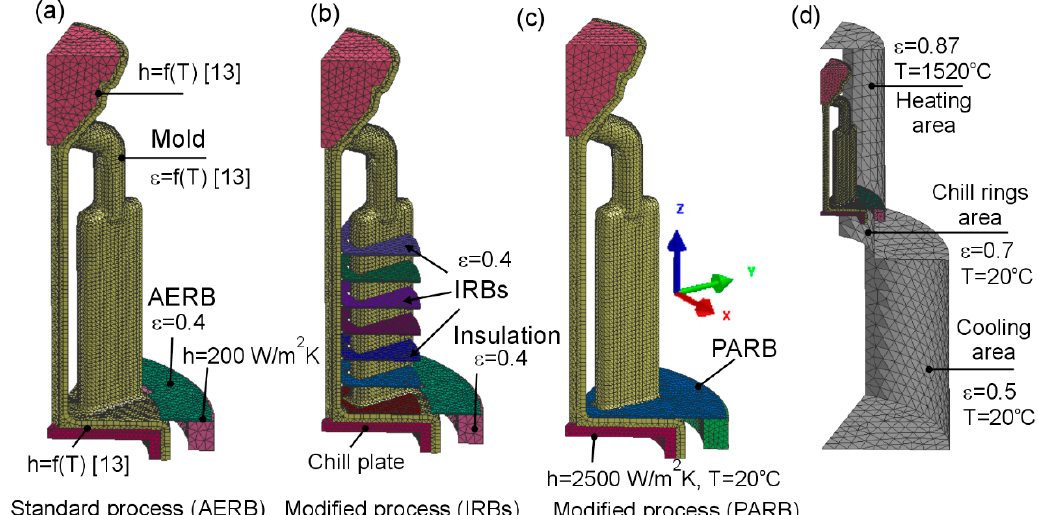
Figure 2. Finite elements mesh generated on model assembly for ( a ) standard process with adjusted external radiation baffle (AERB); ( b ) modified process with inner radiation baffles (IRBs); ( c ) modified process with perfect adjusted radiation baffle (PARB); ( d ) inner surface of heating and the cooling chamber of the furnace (enclosure), where h is interface heat transfer coefficient, ε is emissivity of surface.